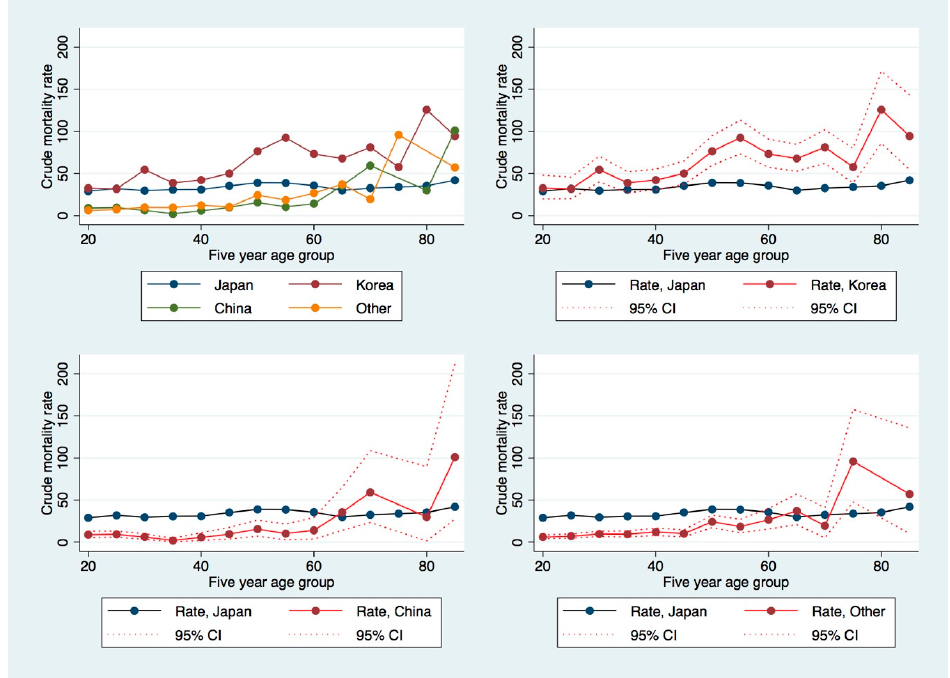
Figure 2. Age-specific crude suicide mortality rates by nationality for women. Clockwise from top left: age-specific rates for Japan, China, Korea, and all other countries; age-specific rates for Korea, all other nations, and China, respectively, with 95% confidence interval and Japanese mortality rates in blue as reference.